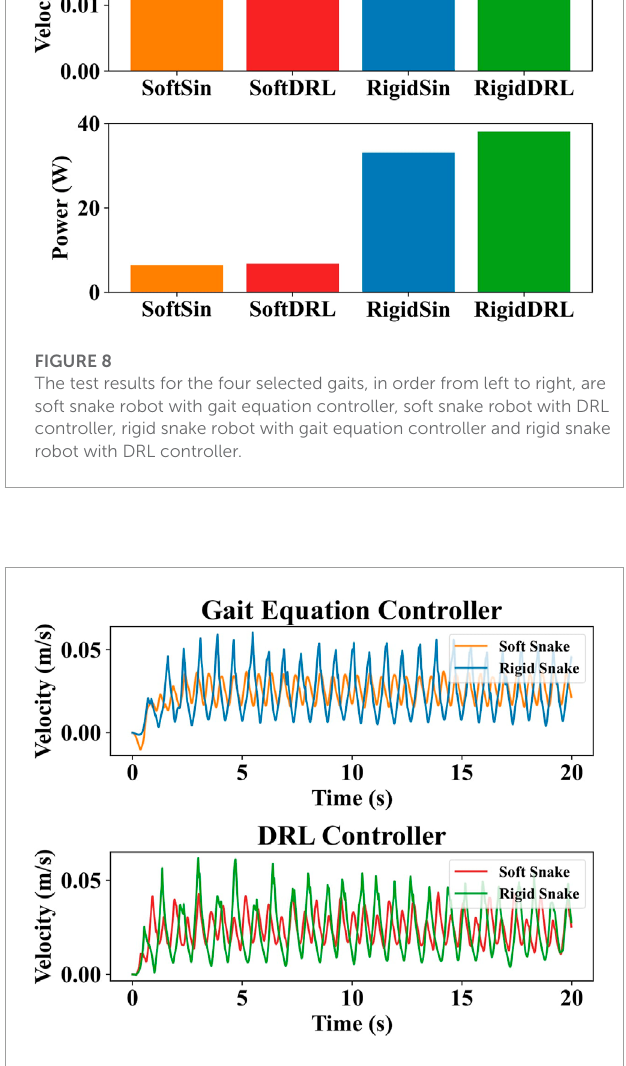
We obtained two groups of training results by adjusting the values of α and β in the reward functions ℝ used for each training to reduce the uncertainty of the